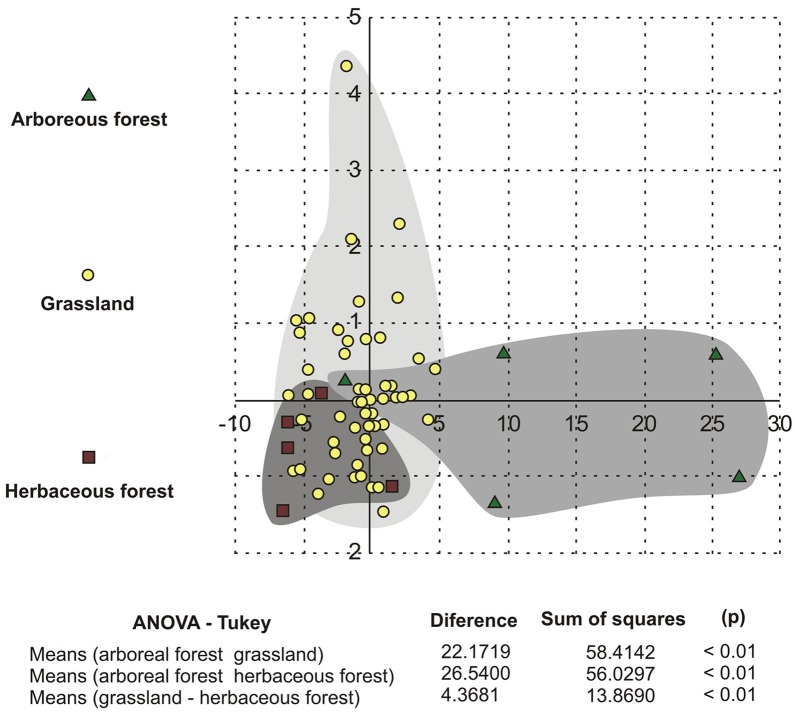
Discriminant analysis of the pollen grain size ordination of the 68 Poaceae species.